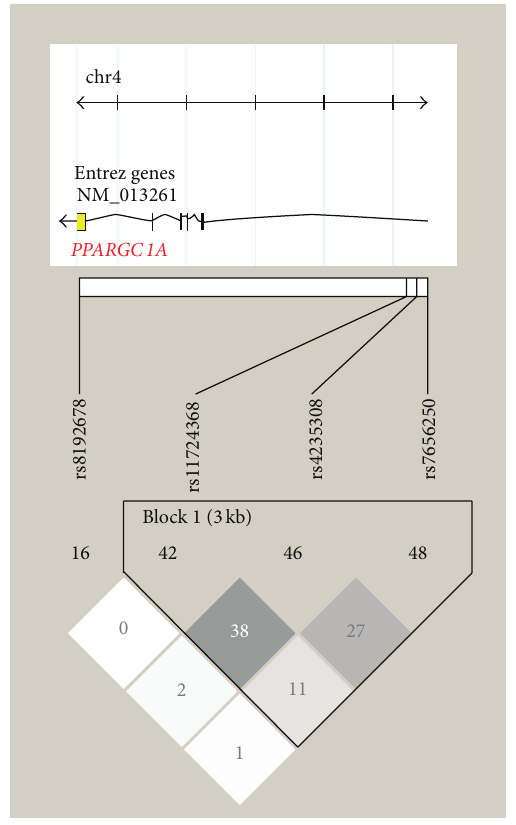
Figure 1: Haploview plot showing linkage disequilibrium (LD) with 𝑟 2 values for four selected SNPs of PPARGC1A gene. Note: black coloring displays strong LD, dark grey displays less strong LD, light grey displays intermediate LD, and white displays weak